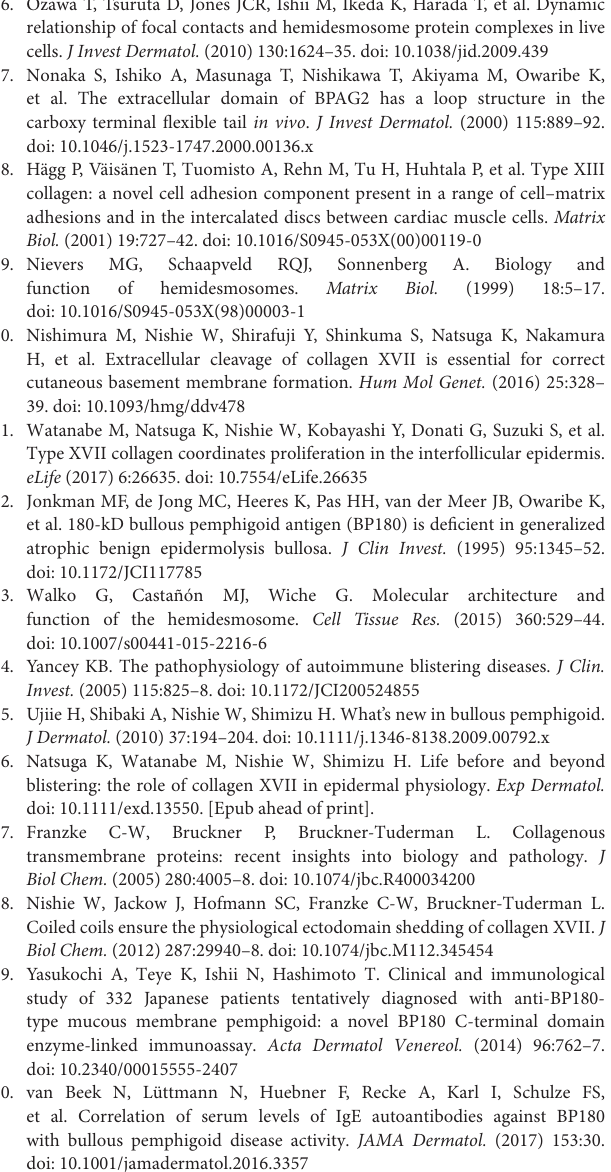
Supplementary Figure S1 | Morphometric features and cell sizes. (A) NHEKs were cocultured with BP-1 IgG or normal IgG. Outlines of single cells at the indicated time points are shown. Arrows indicate the rupture of the plasma membrane. Scale bar 20 µ m. (B) Analysis of the sizes of NHEKs incubated with IgG obtained from three patients with BP (BP-1, BP-2, and BP-3) or normal IgG. Images of nuclear staining were used to clearly segment the cells, and phase-contrast images were used to calculate cell sizes. Yellow dots indicate the average cell size. Approximately 1,500 cells from each group were analyzed. Student’s t -test was used for the statistical analysis. ∗ p -value <